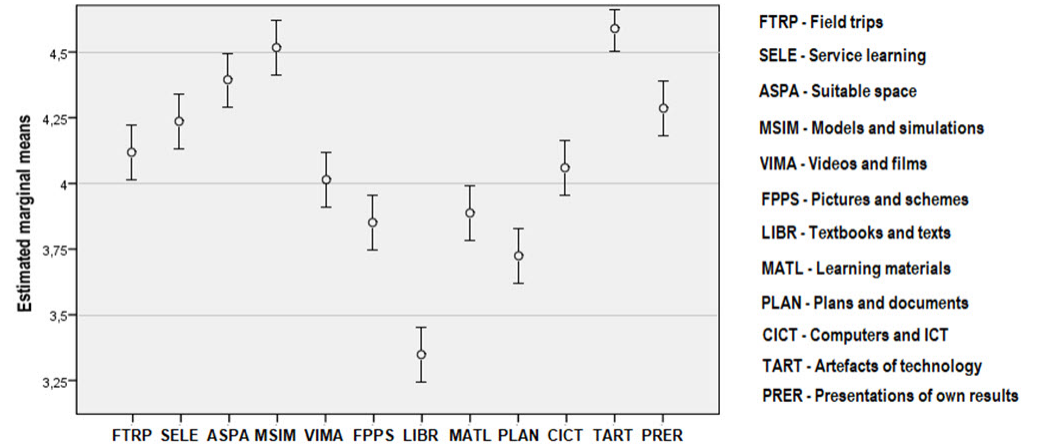
Figure 2. Estimates of the influence of contextual elements on pupils’